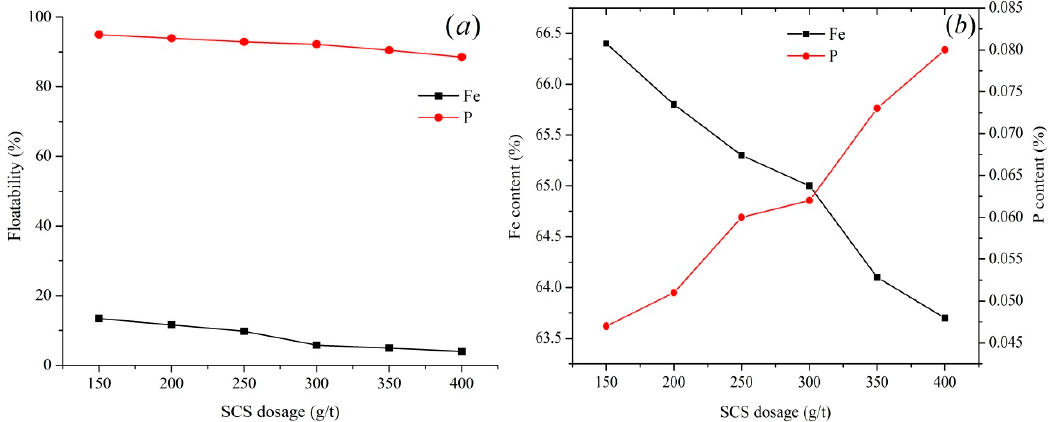
Figure 3. Effect of the SCS concentration on floatability ( a ) and grade ( b ) of Fe and P.